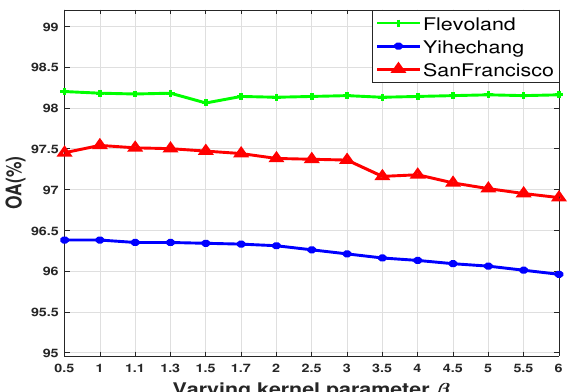
Figure 11. Impact of the kernel parameter β for three PolSAR datasets.